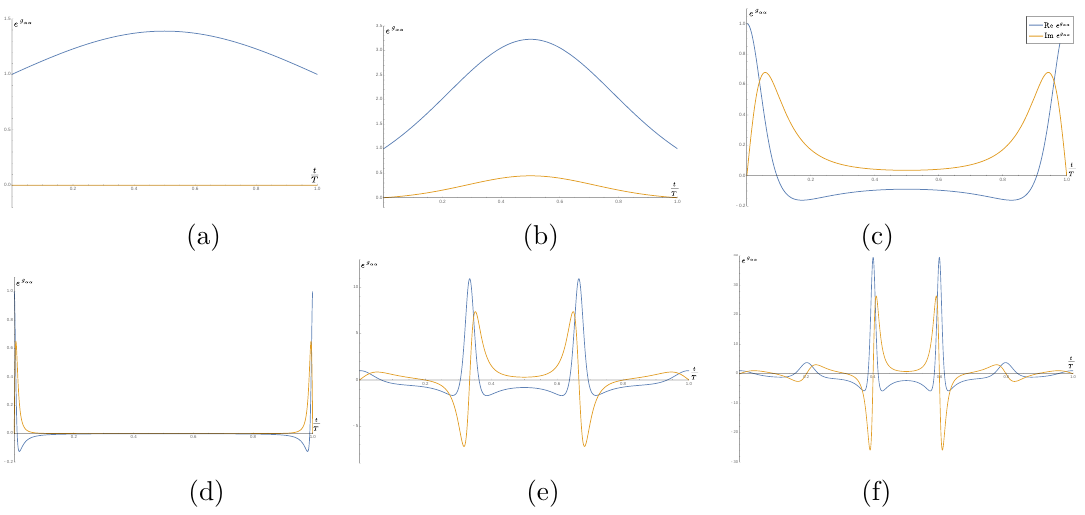
Figure 3 . The solution (3.11) for different times and different solutions of the constraint